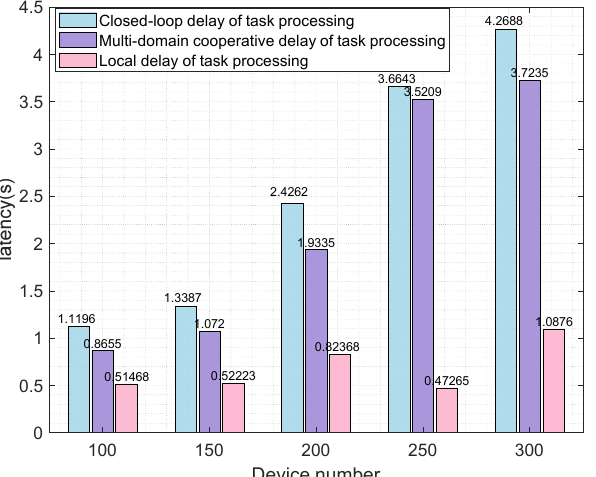
Figure 6. Delay variations in various task processing stages for multiple industrial intelligent termi- nals.